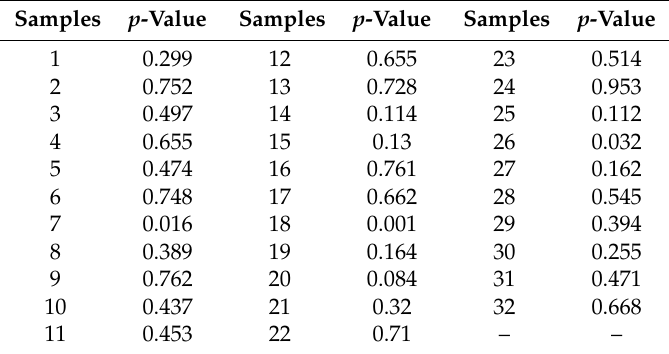
Table 2. p -values between paired